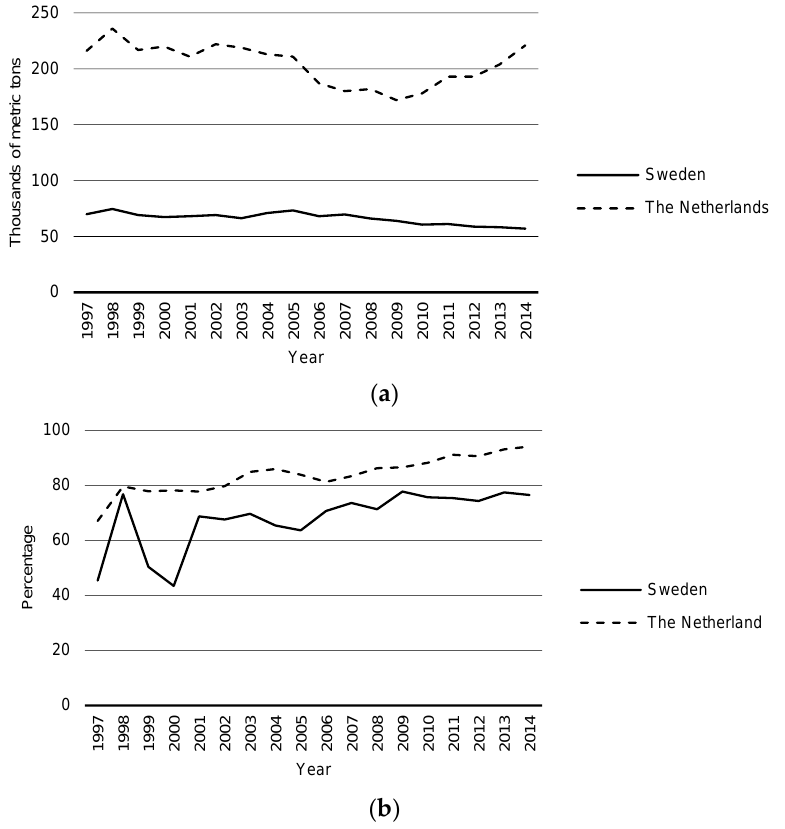
Figure 2. Reported annual metal packaging amounts in Sweden and the Netherlands [40]. ( a ) Generated waste amounts, adapted from [41] with permission from the copyright holder; ( b ) recycled amounts.